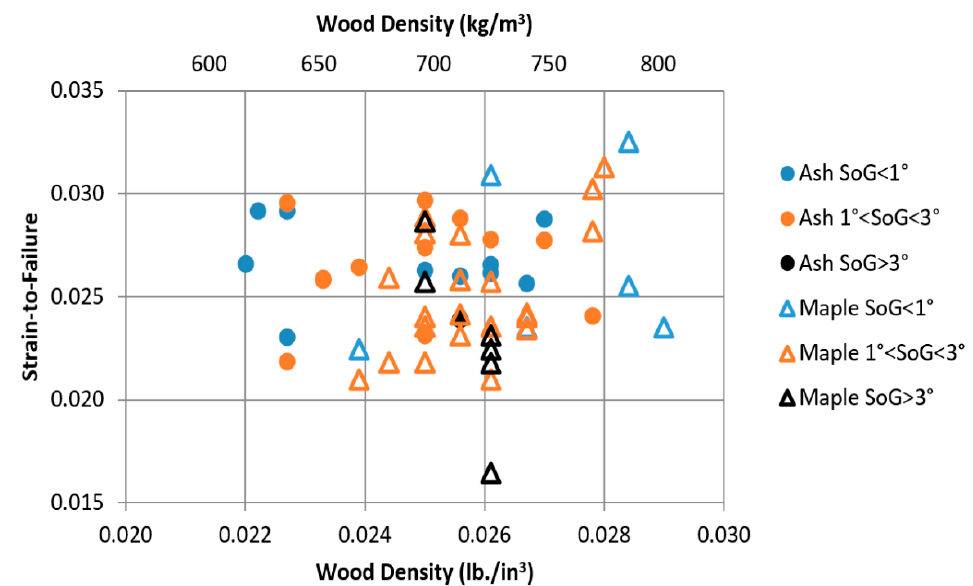
Figure 7. Strain-to-failure of ash samples impacted on the edge-grain and maple samples impacted on the face-grain. All samples are sorted by slope-of-grain (SoG).